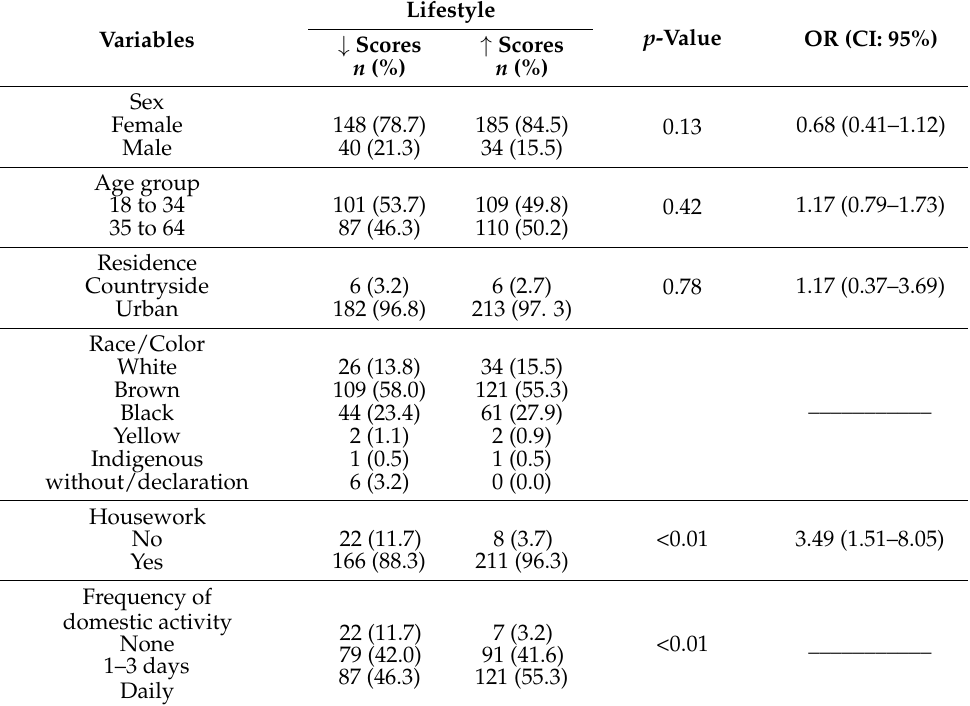
Table 1. Bivariate analysis of the association between lifestyle dichotomized into minor ( ↓ ) and major ( ↑ ) scores and sociodemographic variables of health professionals in pediatric